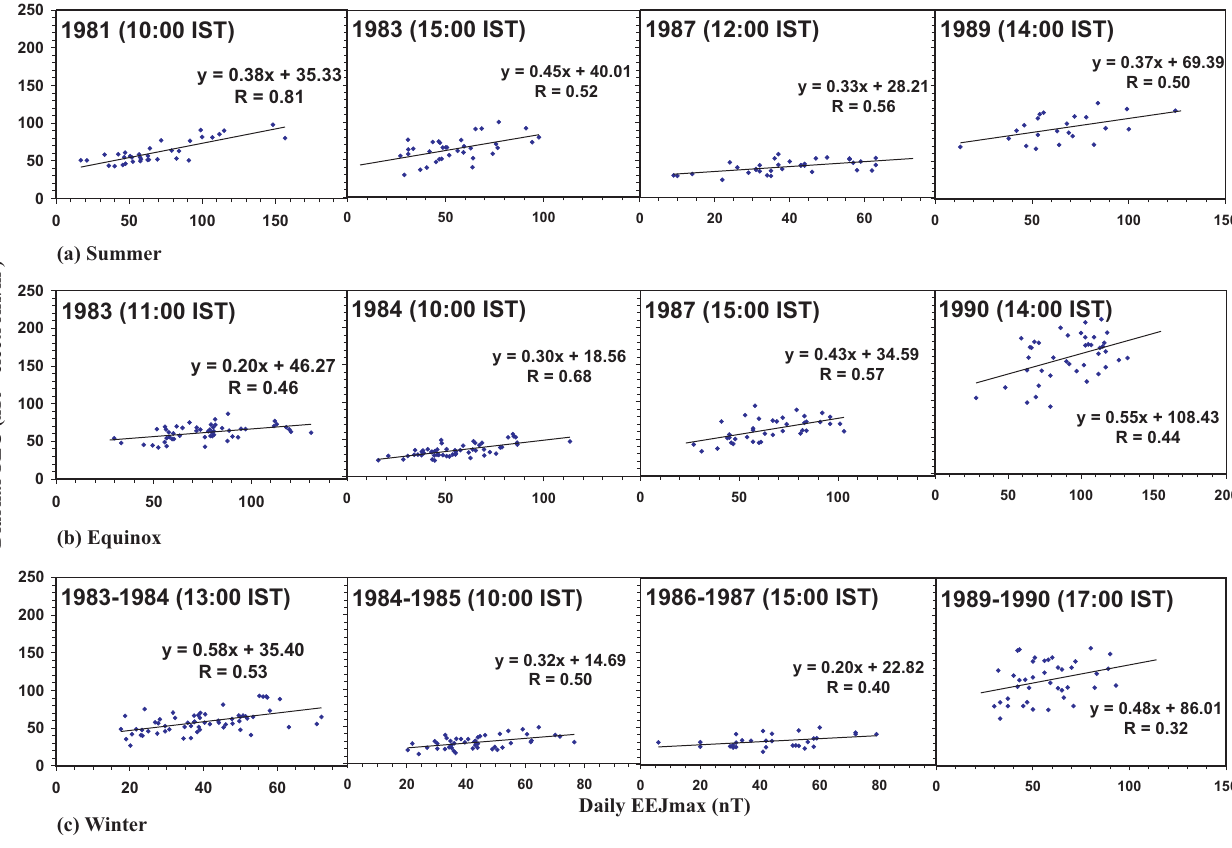
the anomaly crest as reflected in lower TEC value around the 18:00 IST. An inspection of the available fo F2 data from an equatorial station Kodaikanal (geographic latitude 10.25 ◦ N, longitude 77.5 ◦ E, dip 4 ◦ N) reveals a trend of enhanced